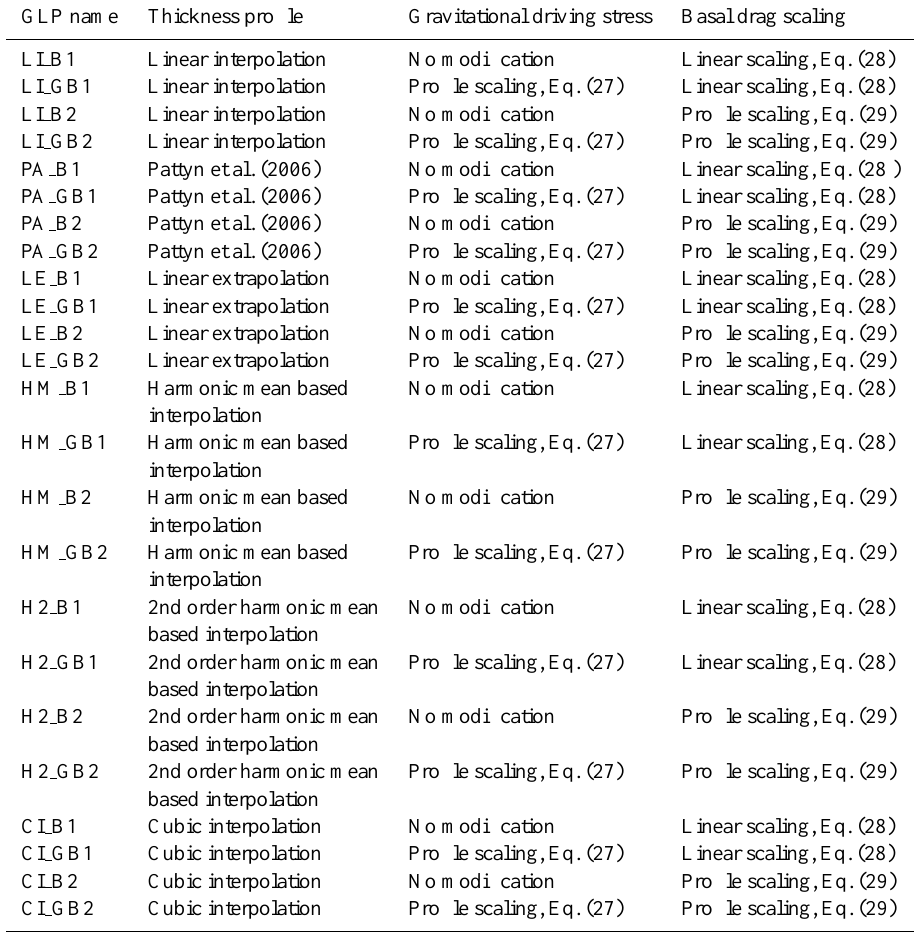
Table 1. Summary of grounding line parameterisations (GLPs) used in this